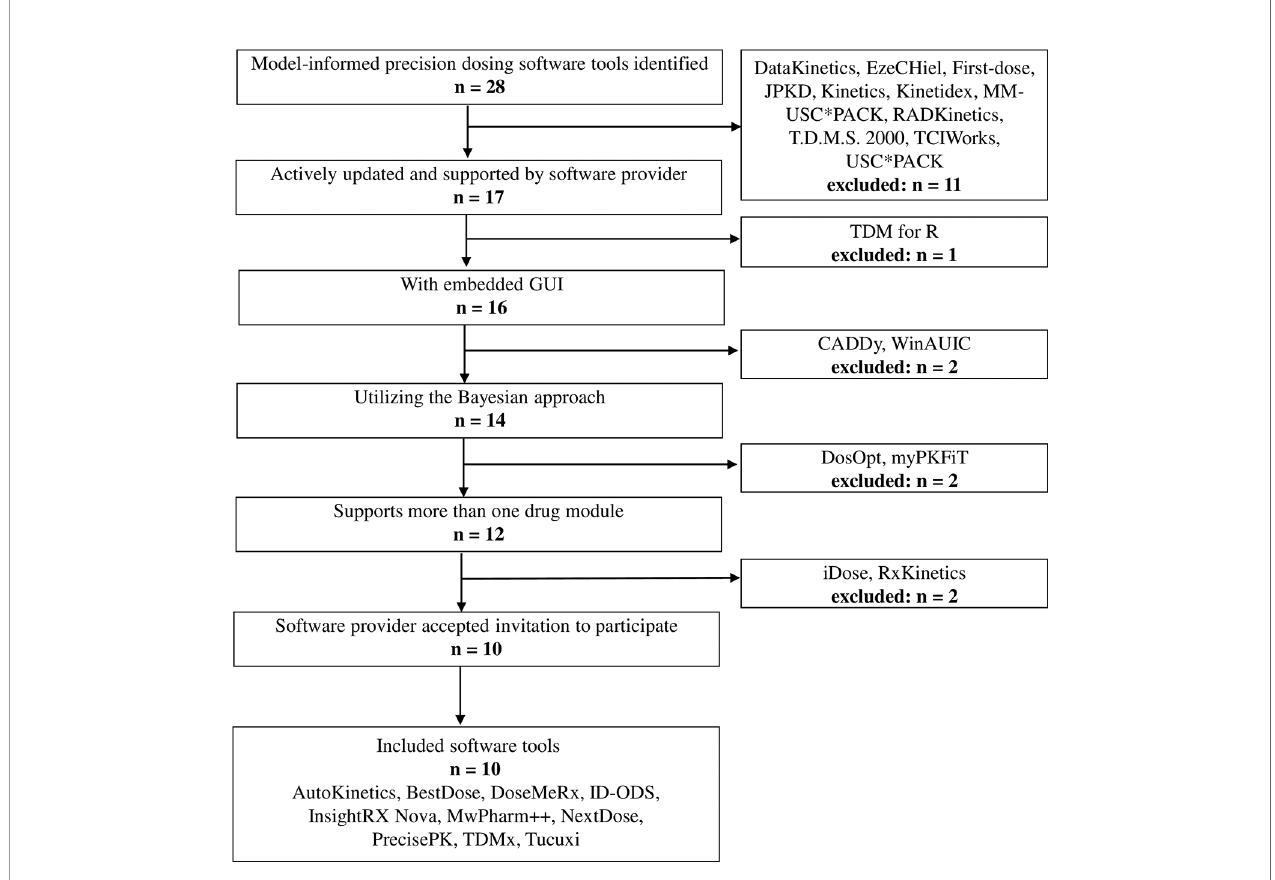
FIGURE 1 | Flowchart of the included and excluded model-informed precision dosing software tools. GUI, graphical user